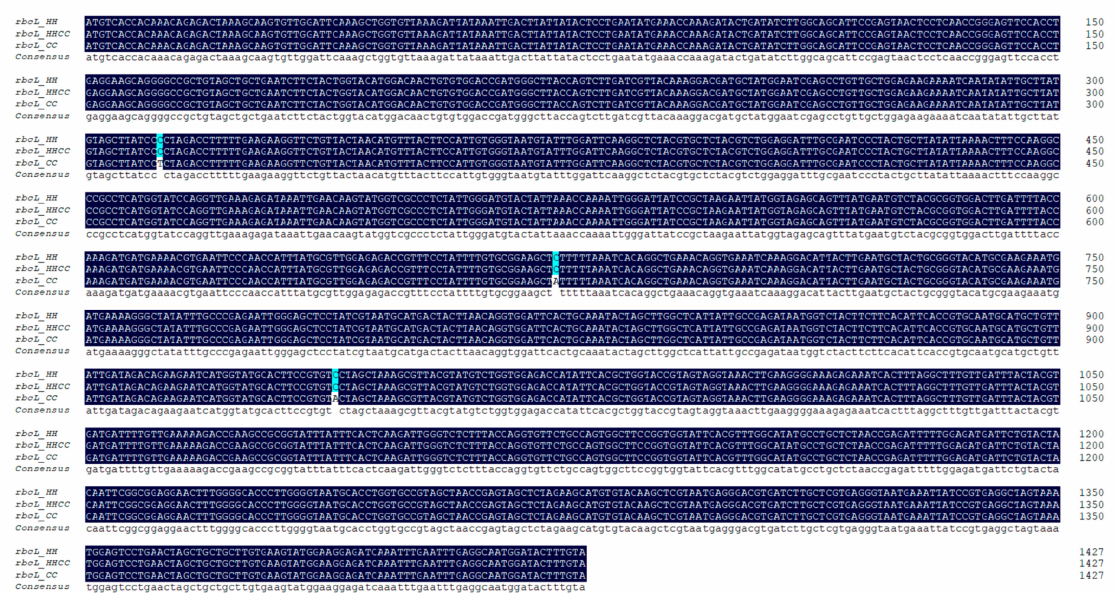
Figure 1. Sequence alignment of allopolyploid Cucumis × hytivus (HHCC) RuBisCO coding gene rbcL with those from the progenitor diploid ( C. hystrix , HH and C. sativus , CC) rbcL genes. The cloned rbcL gene in sampled allotetraploid C. × hytivus is identical to the rbcL gene in its maternal subspecies Cucumis hystrix (HH).